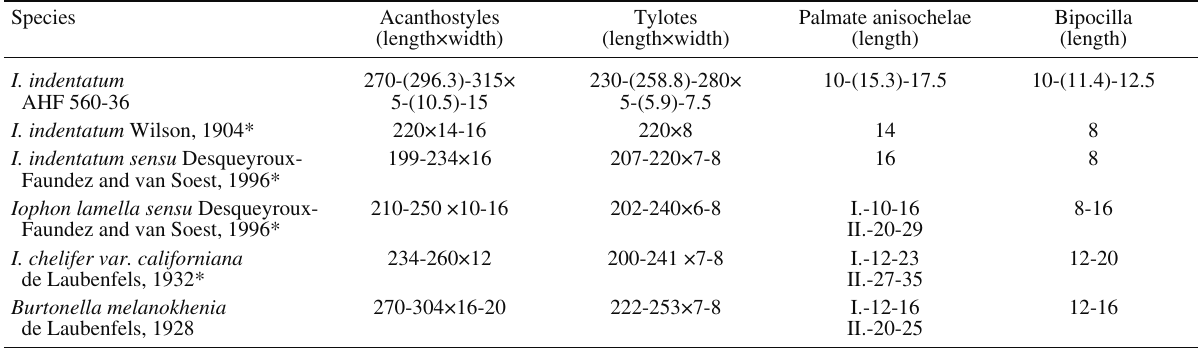
Table 6. – Comparative table of spicule categories of Iophon indentatum Wilson, 1904 and Iophon lamella Wilson, 1904.Values are ex- pressed in minimum-average-maximum (μm).* Spicules measurements from the original description.